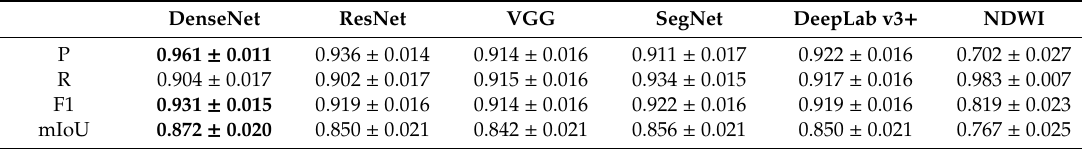
Table 3. The derived P, R, F1score and mIoU of the VGG, ResNet, DenseNet, SegNet, DeepLab v3 + and NDWI models with 95% confidence interval. The optimal value for each metric is shown in bold. DenseNet